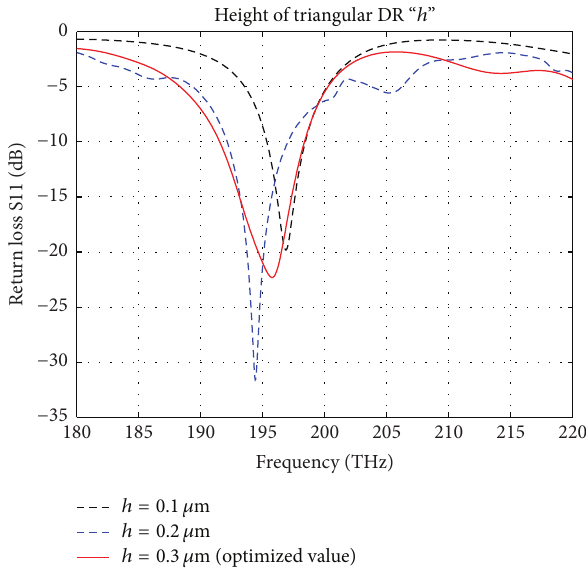
Figure 5: Varied height of triangular DR.